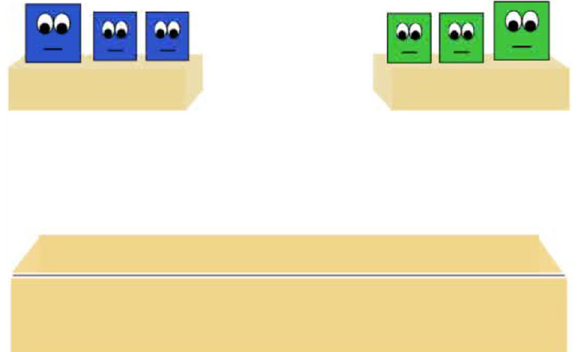
Figure 1. Example of the two groups introduced at the beginning of Experiment 1. Each group consisted of three